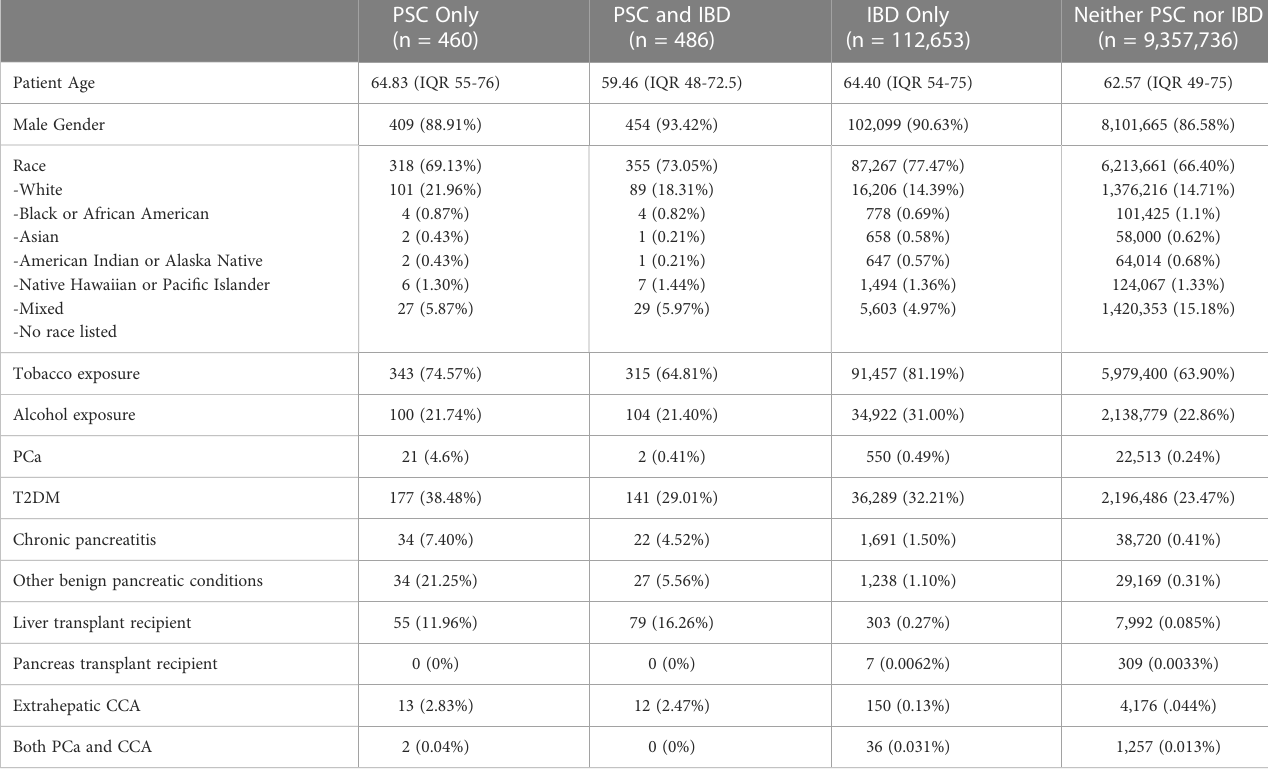
TABLE 1 Clinical characteristics of patients with: PSC only, IBD only, both PSC and IBD, and patients with neither